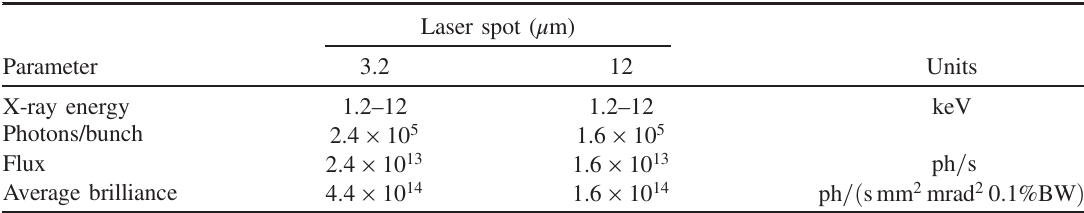
TABLE III. Desired light source parameters. Flux and brilliance reported for top x-ray energy, reduced for lower energies.